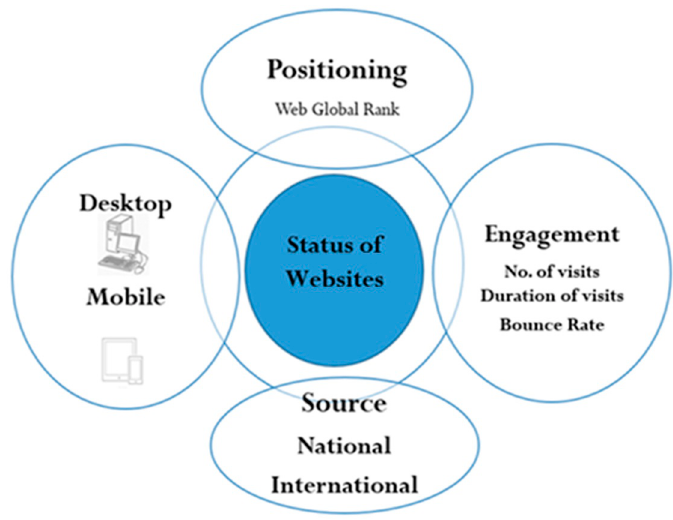
Figure 1. Parameters and associated variables of analysis.